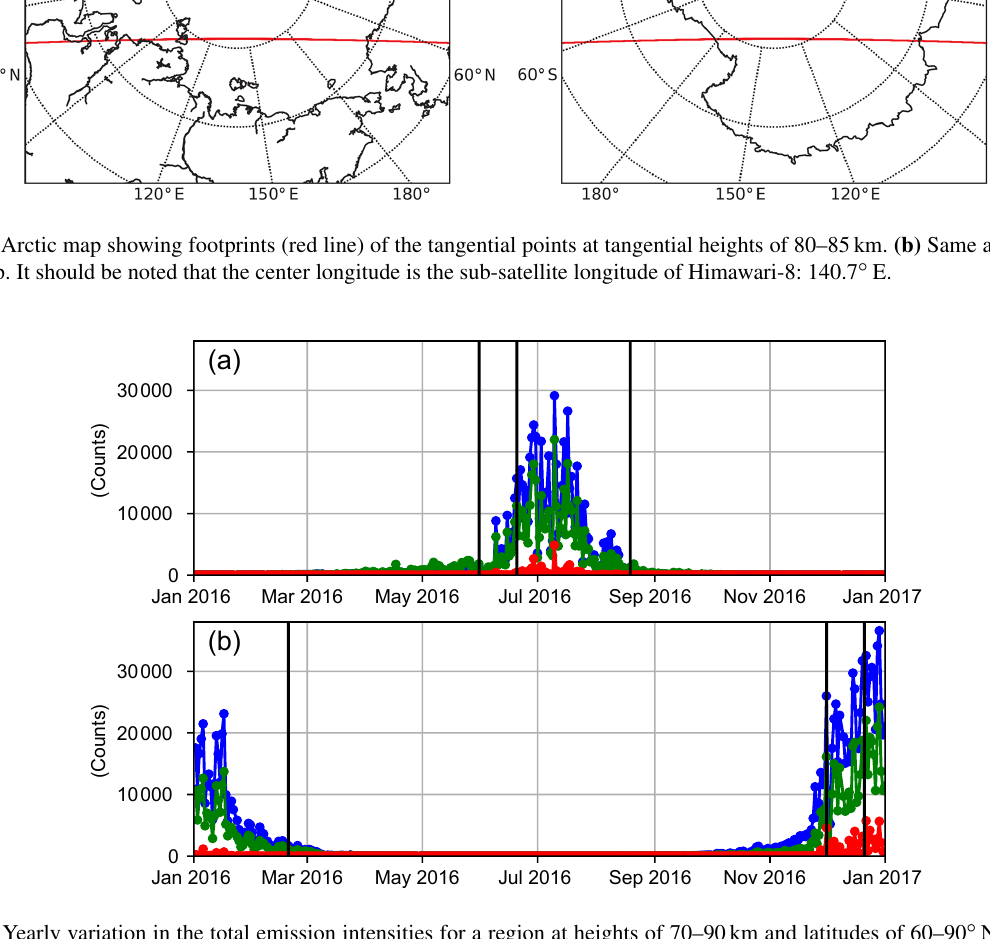
Figure 4. (a) Yearly variation in the total emission intensities for a region at heights of 70–90km and latitudes of 60–90 ◦ N in 2016. Blue, green, and red lines correspond to the blue, green, and red visible bands, respectively. It should be noted that the upper limit of the latitude range is actually ∼ 81 ◦ , that is, the highest latitude of the tangential points when the height range is set to 70–90km. Vertical black lines indicate the northern summer solstice in 2016 (i.e., 20 June 2016), 20 days before the solstice (i.e., 31 May 2016), and 60 days after the solstice (i.e., 19 August 2016), in reference to the typical PMC period. (b) Same as (a) , but for a region at heights of 70–90km and latitudes of 60–90 ◦ S. Vertical black lines indicate the southern summer solstice in 2016 (i.e., 21 December 2016), 20 days before the solstice